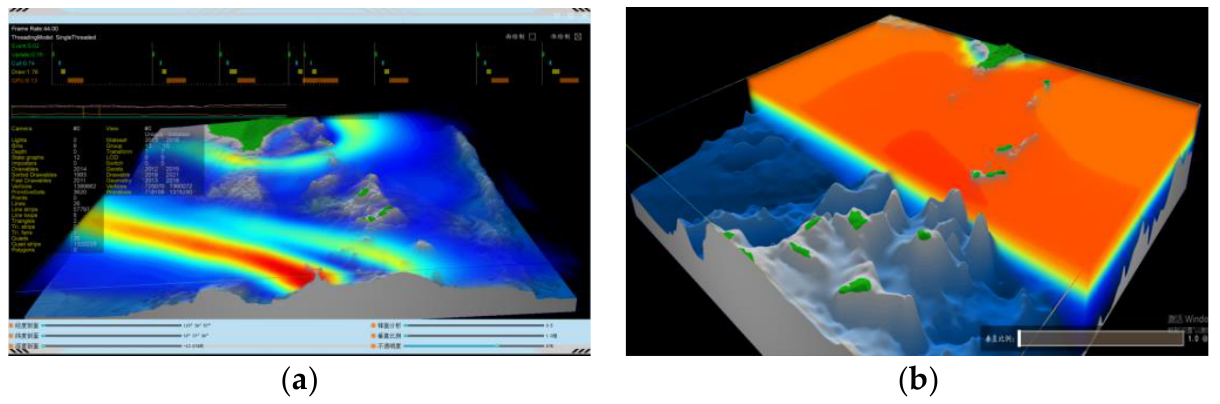
Figure 9. Isosurface visualization. ( a ) is the debugging interface, ( b ) is the area display.